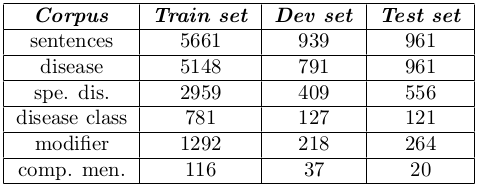
Table from the paper: Recurrent neural network models for disease name recognition using domain invariant features
Table text:
Corpus
Trainset
Devset
Testset
sentences
5661
939
961
disease
5148
791
961
spe. dis.
2959
409
556
disease class
781
127
121
modiﬁer
1292
218
264
comp. men.
116
37
20